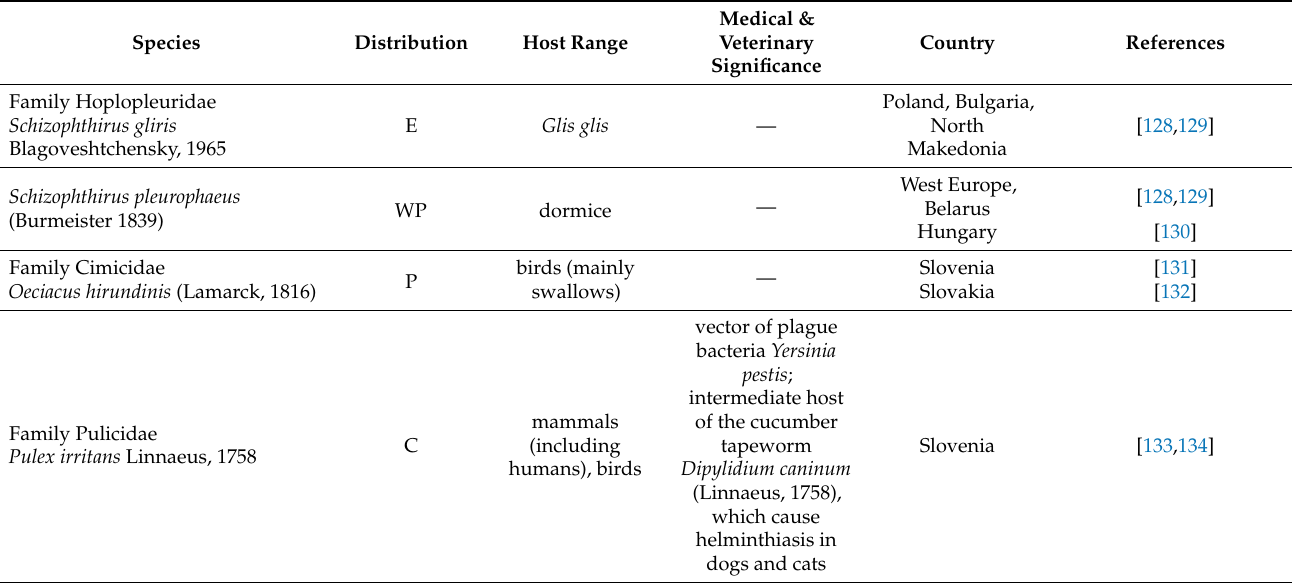
Table 4. Ectoparasites of Glis glis in the Western